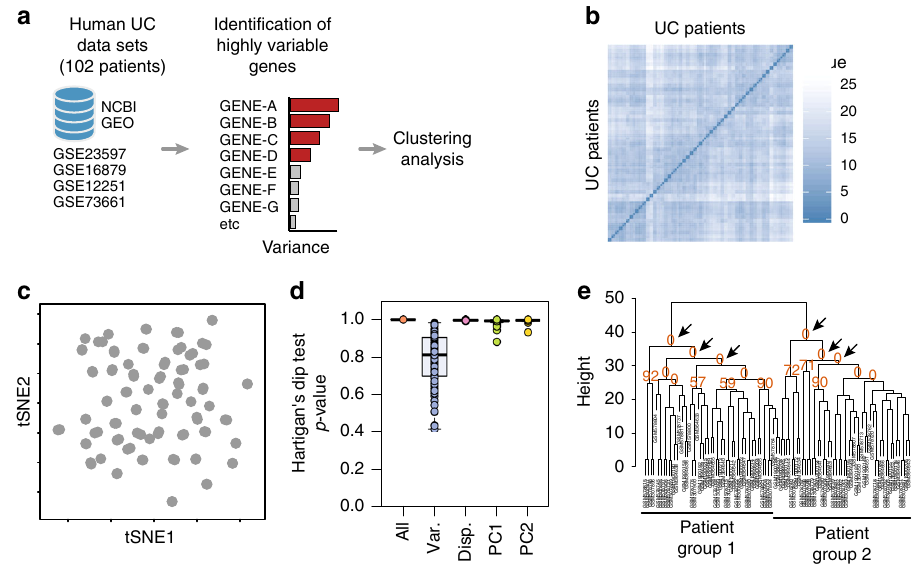
Fig. 1 Human ulcerative colitis transcriptional signature does not cluster patients into molecular pro fi les. a Schematic representation of the strategy used for patient group identi fi cation, in which four publicly available data sets were combined. Gene ranking was done using the most variable genes in the human data set, which were used for clustering analysis. b Sample dissimilarity heatmaps for visual analysis of clustering tendency (VAT), comparing the human data set using the top 100 variable genes. c t-SNE plot using the top 100 variable genes in the human data set. Each point represents a patient sample. d Hartigan ’ s Dip test for clustering tendency using all genes in the data set, the top 100 variable genes, the top 100 highly dispersed genes, or the top 100 leading genes in the principal components. e Bootstrapping analysis of hierarchical clustering, comparing the human data set using the top 100 variable genes in the human data set. Numbers in orange indicate the approximately unbiased (AU) p -value, shown as a percentage. AU closer to zero indicates a cluster with low stability. Boxplot represents the median (center line, second quantile), fi rst, and third quantiles (box) and whiskers extending 1.5 times the interquartile range (IQR)